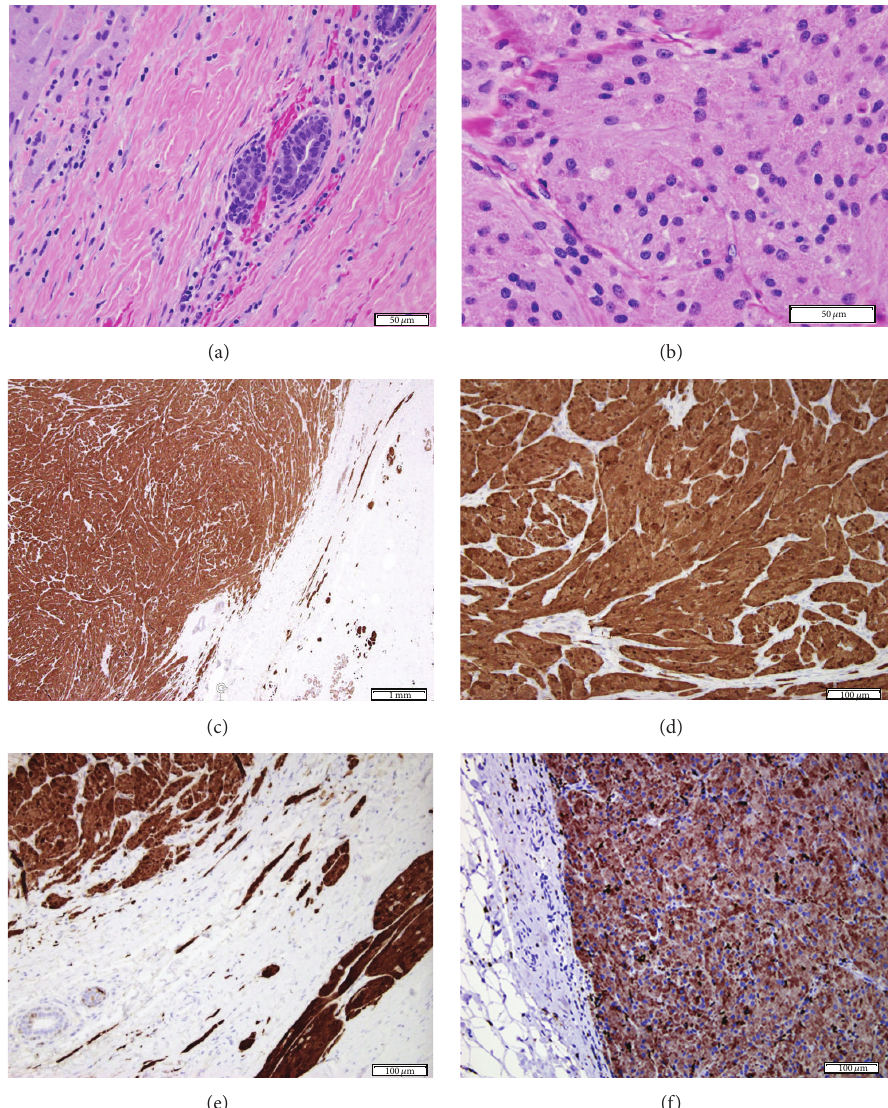
Figure 2: (a) Margin of tumor, cords and files of tumor cells in compressed collagenous stroma, with normal ducts, minimal inflammatory reaction (H&E). (b) Center of the tumor; granularity of the abundant eosinophilic cytoplasm is apparent (H&E). (c) Low power architecture of tumor, with swirling cords; peripherally entrapped normal duct (middle of picture); compressed, minimally infiltrative strands on the right, along with normal breast lobules Immunostain for S100. (d) Center of the tumor, positive for S100 immunohistochemical stain. (e) Margin of the tumor (Immunostain for S100); short infiltrative tumor strands (right lower quadrant of image) in compressed stroma (right upper quadrant), entrapping normal ducts (left lower corner) by the tumor margin (left upper quadrant). (f) Diffuse immunohistochemical staining of the tumor with